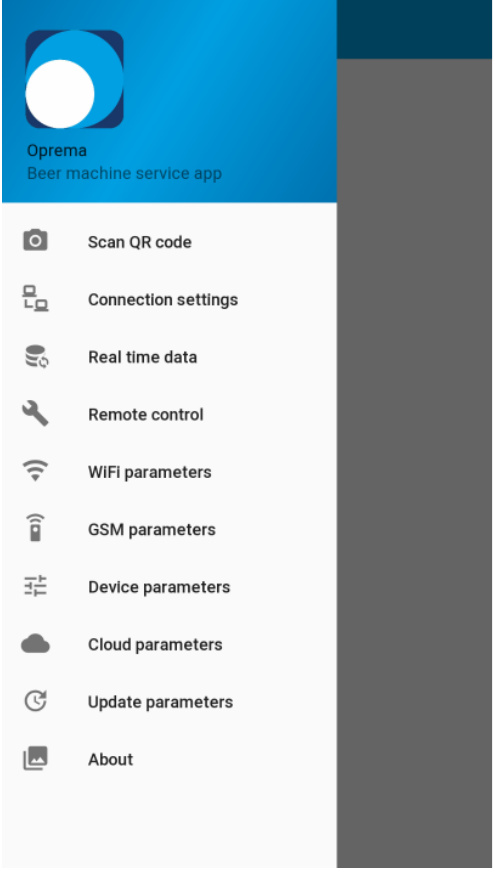
Figure 13. Service mobile application